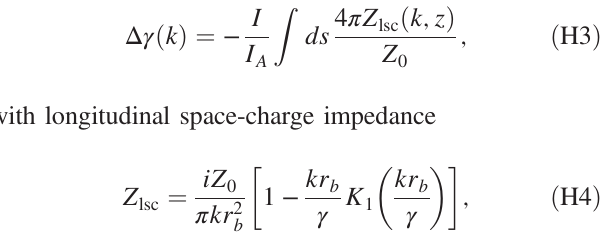
Gaussian component: 1 keV (red line) and 3 keV (blue